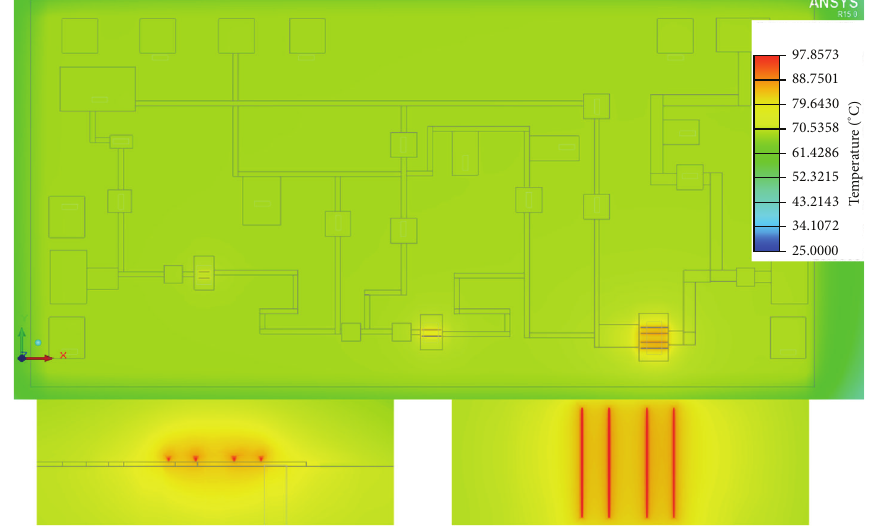
Figure 9: The simulation result of the designed PA using